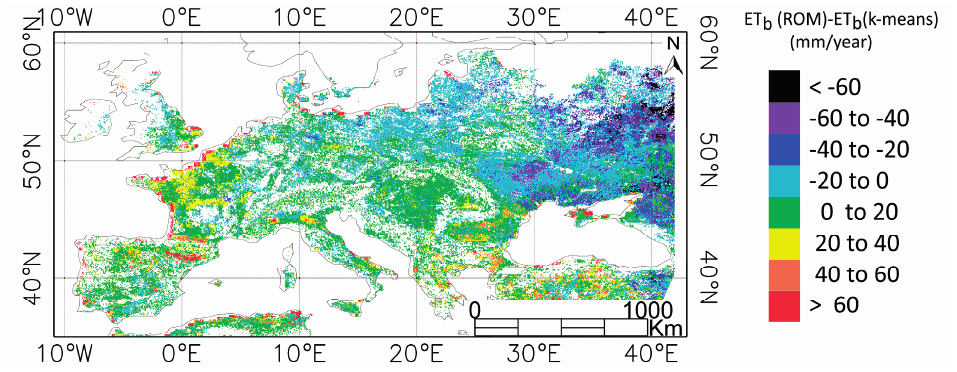
(ROM) and ET (k–means) obtained for the year b b